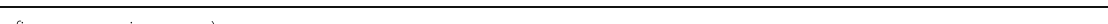
(See figure on previous page.) Fig. 5 Effects of HMGB1 peptide analyzed by single-cell RNA-seq. A Summarized results are shown by Uniform Manifold Approximation and Projection (UMAP) plots. B The numbers of differentially expressed genes ( q value < 0.05) in each partition in A are shown. C Reclustered UMAP of macrophage populations. D Frequencies of immune cells in each cluster in A in the normal saline (NS) control and HMGB1 peptide-treated groups. E The frequencies of macrophage subtypes in C in the normal saline (NS) control and HMGB1 peptide-treated groups. F Gene Ontology biological process functional analysis of subtypes 5, 6, and 7. G Gene Ontology analysis using genes that were solely expressed by macrophage